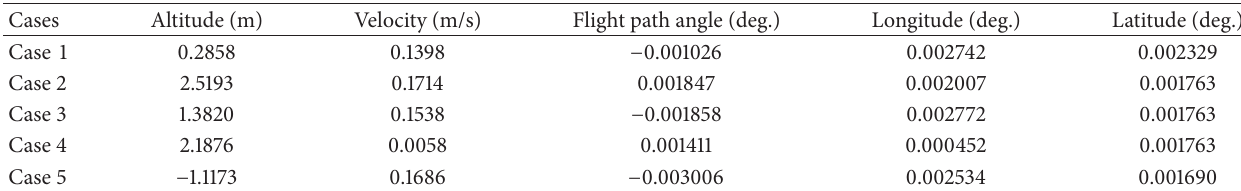
Table 5: Final errors for various integral